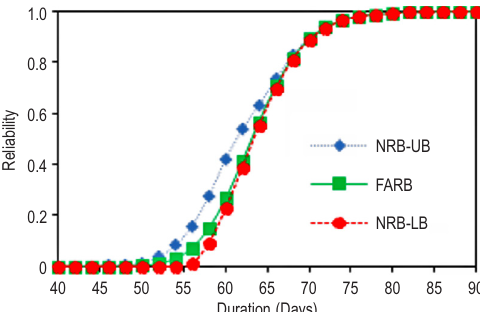
Fig. 2. Reliability of project completion time for different target durations